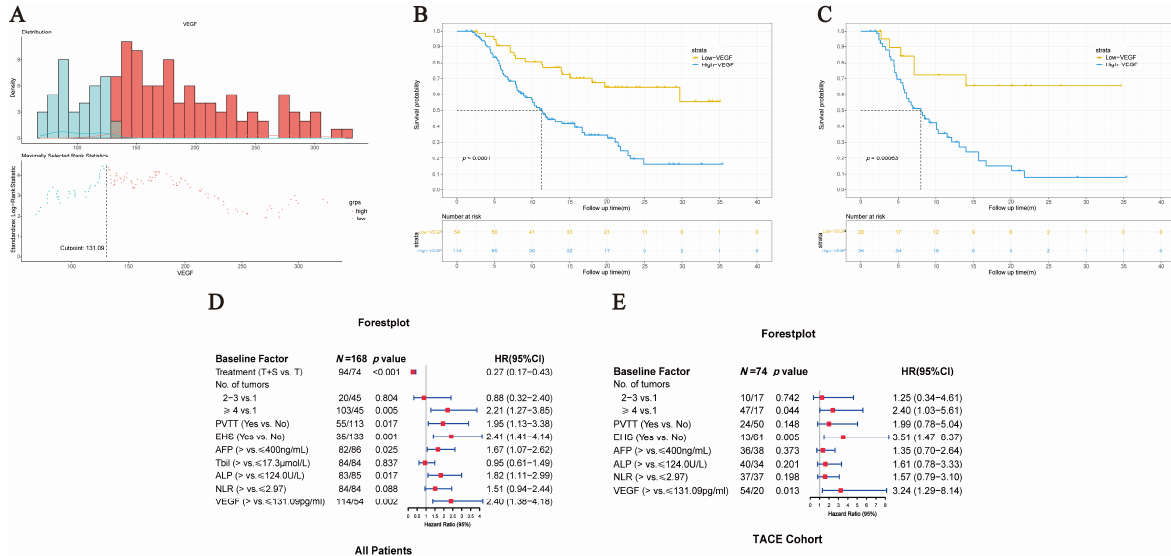
Figure 3. The optimal cutoff value for VEGF and prognosis factors for unresectable HCC. ( A ) The optimal cutoff value for VEGF based on the maximally selected rank statistics. Kaplan–Meier overall survival (OS) curves for baseline VEGF ( B ) in all patients and ( C ) in the TACE cohort. Prognosis factors for unresectable HCC ( D ) in all patients and ( E ) in the TACE cohort based on multivariate